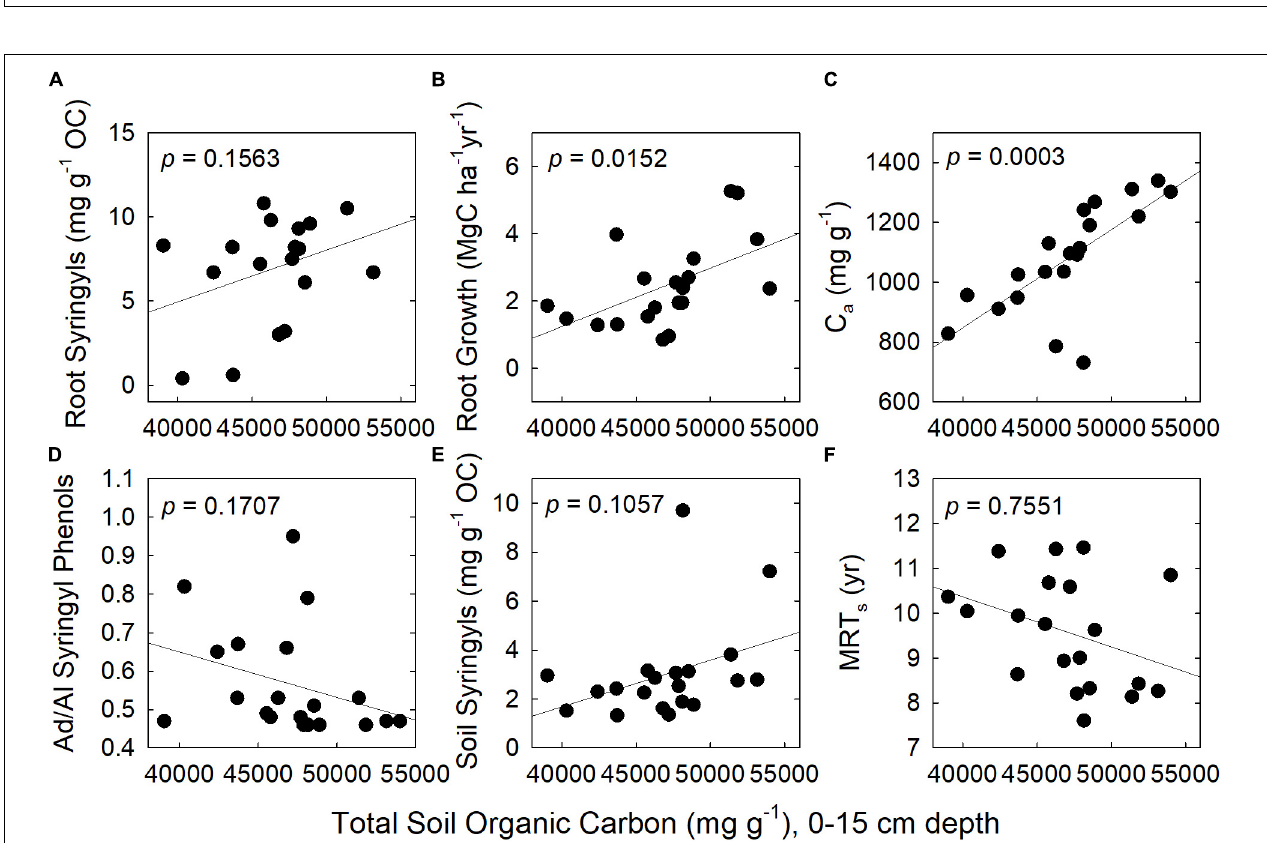
FIGURE 2 | Correlations between total SOC and six explanatory variables. They are: (A) Root syringyl phenols; (B) Fine-root growth; (C) Size of the active soil pool, C a ; (D) Acid/Aldehyde of Syringyl phenols in soil; (E) Soil syringyl phenols; and (F) Mean Residence Time of the slow pool, MRT s . N = 20 plots.